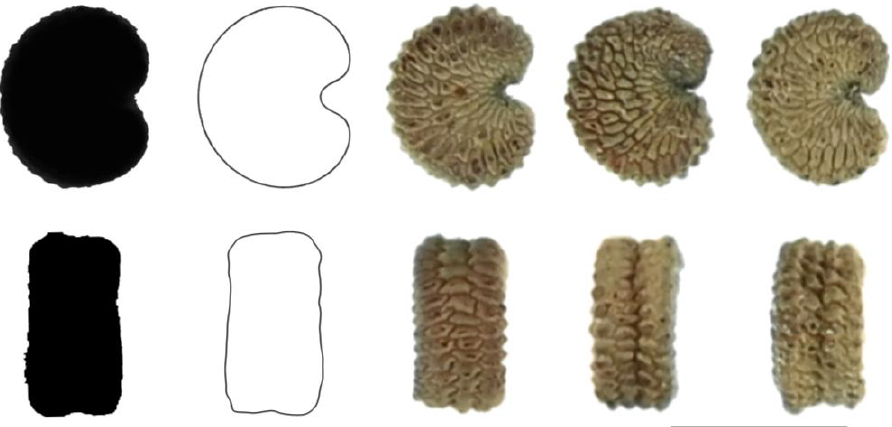
Figure 15. Silene chlorantha : average silhouettes (left), the models giving best scores with 20 seeds (LM5 and DM11), and three representative images for the lateral (above) and dorsal (below) seed views. Bar represents 1 mm.